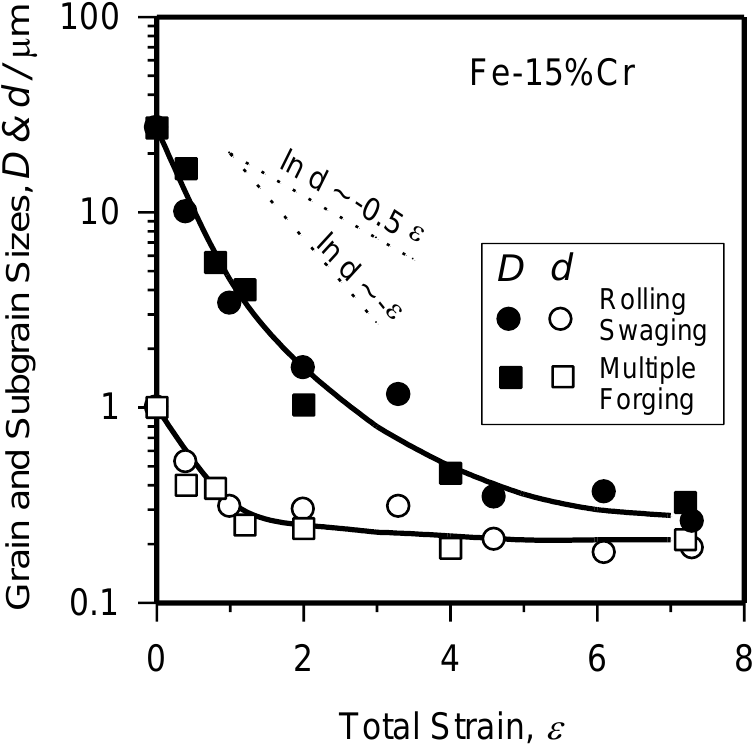
Figure 24. Effect of processing method on the transverse grain (D) and subgrain (d) sizes in a Fe-15%Cr stainless steel [39].